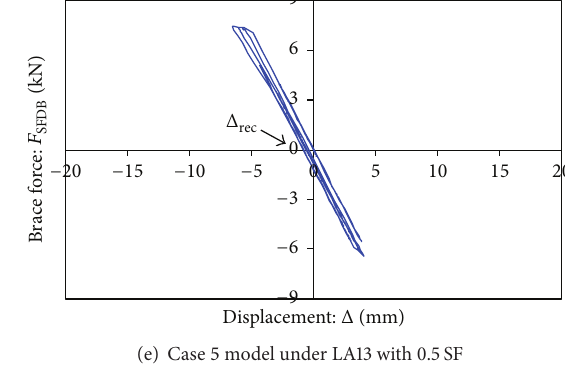
corresponding to SFDB model cases presented in Table